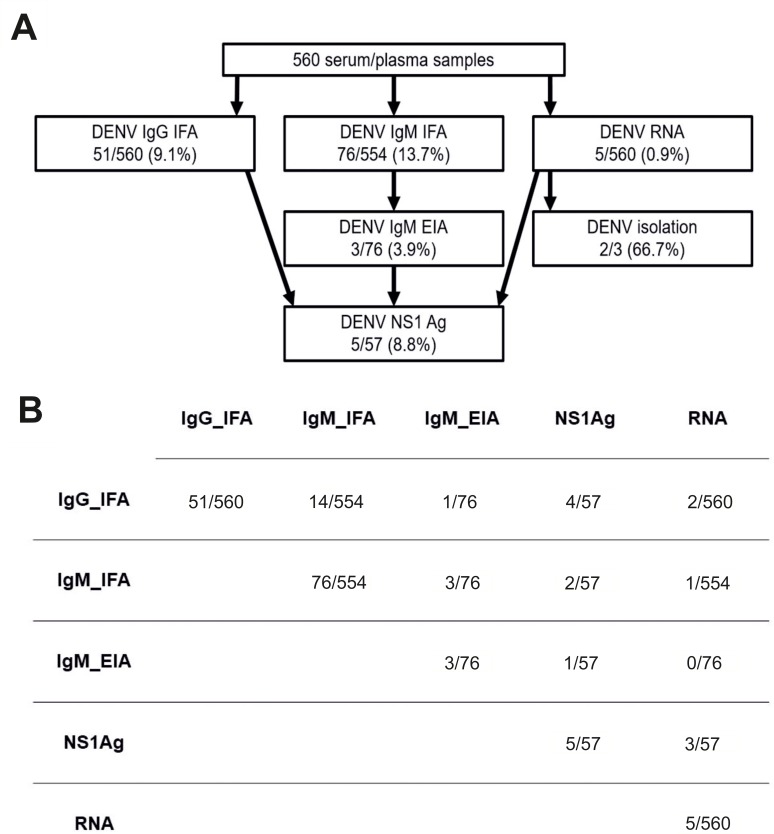
Diagnostic assays and results: a) workflow and results for flaviviral diagnostic tests; b) dengue serological assays and RT-PCR results.